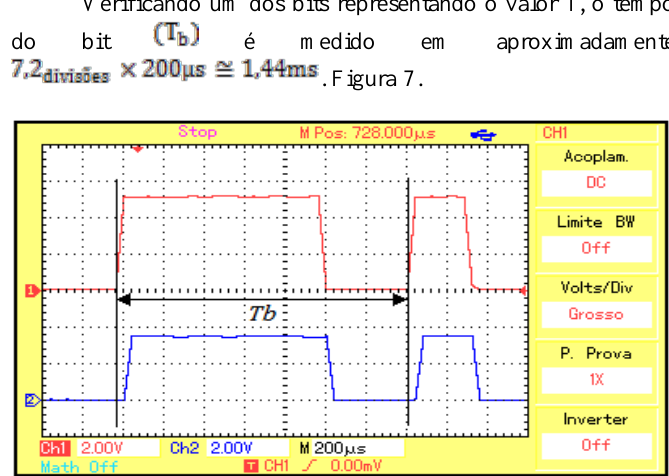
Figura 7: Imagem do primeiro valor alto da sequência. Fonte: Autores, (2018).